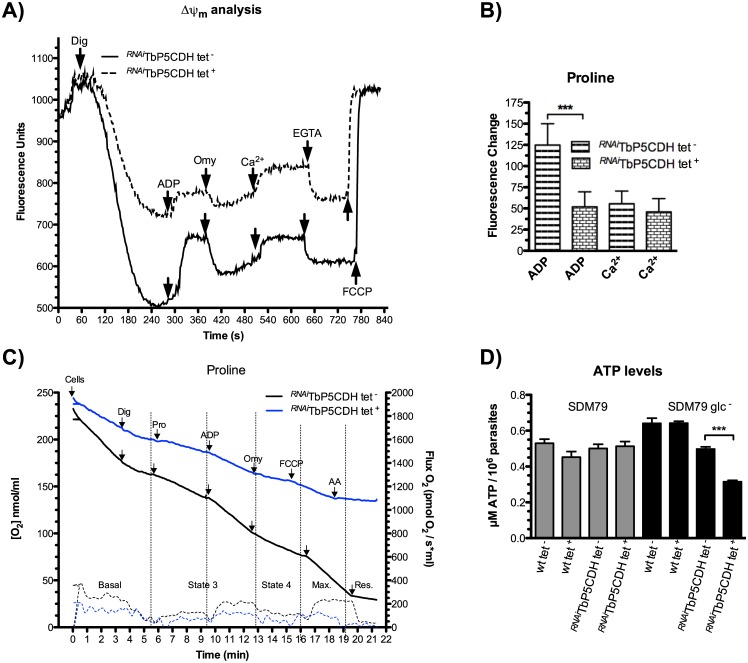
Assessment of mitochondrial function in PCF trypanosomes.The capacity of mitochondrial inner membrane to retain safranin dye was monitored in digitonized cells. Changes in the safranin fluorescence are representative of the mitochondrial inner membrane potential (ΔΨm) in PCFs. RNAiTbP5CDH cells were selectively permeabilized with digitonin until fluorescence quenching was stabilized. Then, 250 μM ADP and 50 μM calcium chloride (Ca2+) were added to induce depolarization of the mitochondrial (mt)-inner membrane or 0.5 μg/ml oligomycin (Omy) and 500 μM EGTA to revert it, as indicated. Finally, 0.3 μM FCCP was added to collapse the proton gradient, thus releasing the dye. B) Changes in fluorescence obtained after ADP or Ca2+ addition were compared between tet-/+ cells. Statistical differences were obtained by unpaired t-test (* p<0.05). C) Oxygen consumption rates in PCFs were determined in intact cells (Basal), followed by digitonin addition to selectively permeabilize mt-inner membrane. Then, L-proline (5 mM) was added as mitochondrial substrate and respiration at state 3 was obtained after addition of ADP (250 μM). Inhibition of Fo/F1-ATP synthase was induced by oligomycin addition, to induce the non-phosphorylating respiration (state 4). Maximum respiratory capacity (Max.) was analyzed after induction of non-coupled respiration produced by FCCP (0.3 μM). Finally, the residual oxygen consumption (Res) was determined after addition of mitochondrial inhibitor antimycin A (0.5 μM). The plot is representative of four biological replicates, and mean values were detailed in Table 1. D) ATP levels were determined in wt tet-/+ and RNAiTbP5CDH tet-/+ cells grown in either SDM79 or SDM79 glc- media for three days. ATP concentration was extrapolated from the standard curve. Bars represent mean ± SD of total ATP levels relative to parasite number. Statistical differences were determined using unpaired t-test (*** p<0.01).